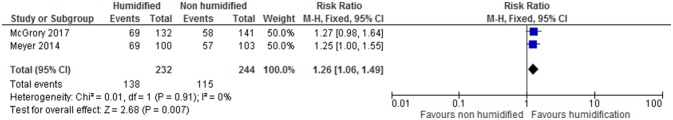
Normothermia on admission (36.5–37.5°C).